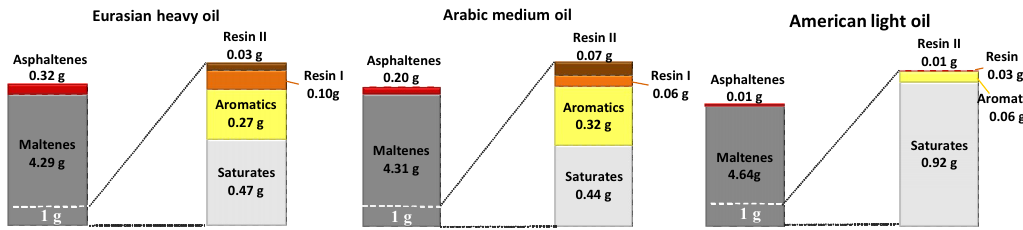
Figure 1. Detailed charts from the extracted amount of asphaltenes and maltenes from 6 g of crude oil, and further extracted saturates, aromatics, resin I and II from 1 g of maltenes of heavy Eurasian oil ( left ), Arabic medium oil ( middle ) and American light oil ( right ).